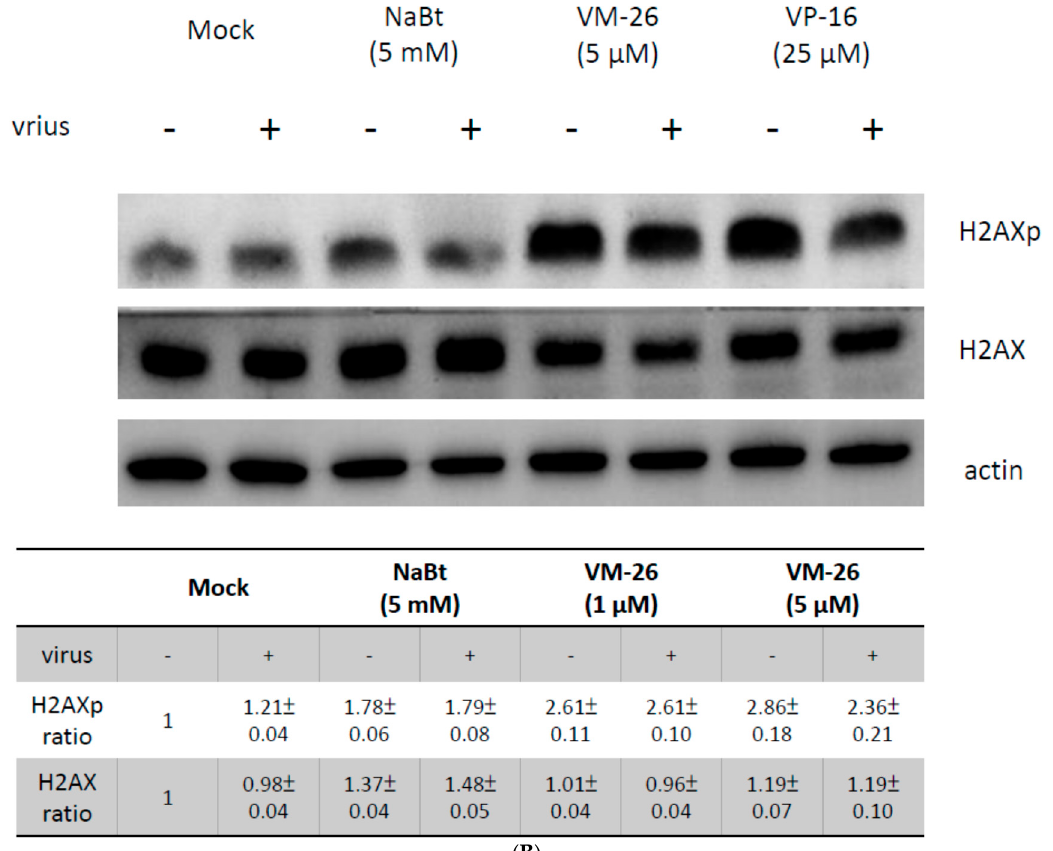
Figure 4. VM-26 can enhance BacMam-mediated gene expression in U-2OS cells by DDR but does not change the acetylation state of histone proteins. ( A ) Western blot analysis of acetylated-histone H4 in U-2OS cells (5 × 10 4 cells seeded in a 24-well plate) treated with NaBt (0.1 or 5 mM) or VM-26 (1 or 5 μ M) by anti-histone H4 acetylation antibody or anti-histone H4 antibody, respectively. Signal intensity of acetylated-histone H4 (histone H4 ac ratio) and non-modified histone H4 (histone H4 ratio) in the Western blot were quantified by Image J software and normalized to the intensity of actin present in the lower panel. RFU (fold) indicated the enhancement of EGFP expression as measured by spectrofluorometer in the vAc-CMV- α Syn·EGFP transduced U-2OS cells under the indicated treatment; ( B ) The DDR were detected by the presence of H2AXp by immunoblot probed with an anti-H2AXp antibody. U-2OS cells (5 × 10 4 cells seeded in a 24-well plate) treated with sodium butyrate or VM-26 were transduced with vAc-CMV- α Syn·EGFP (moi = 100, +) or not transduced ( − ). After 24 h of transduction, the U-2OS cells were lysed and immunoblots were performed with anti-H2AXp antibody or anti-H2AX antibody, respectively. The fold of vAc-CMV- α Syn·EGFP (moi = 100) mediated α Syn·EGFP gene expression in U-2OS cells in the presence of NaBt or VM-26 was determined by spectrofluorometer as mentioned in the Materials and Methods section and is presented as the mean ± SD of three independent experiments. Actin was used as a loading control. Quantification of the H2AXp and H2AX band intensities relative to the expression of actin was presented in the lower panel. All of the data are presented as the mean ± SD of three independent experiments.